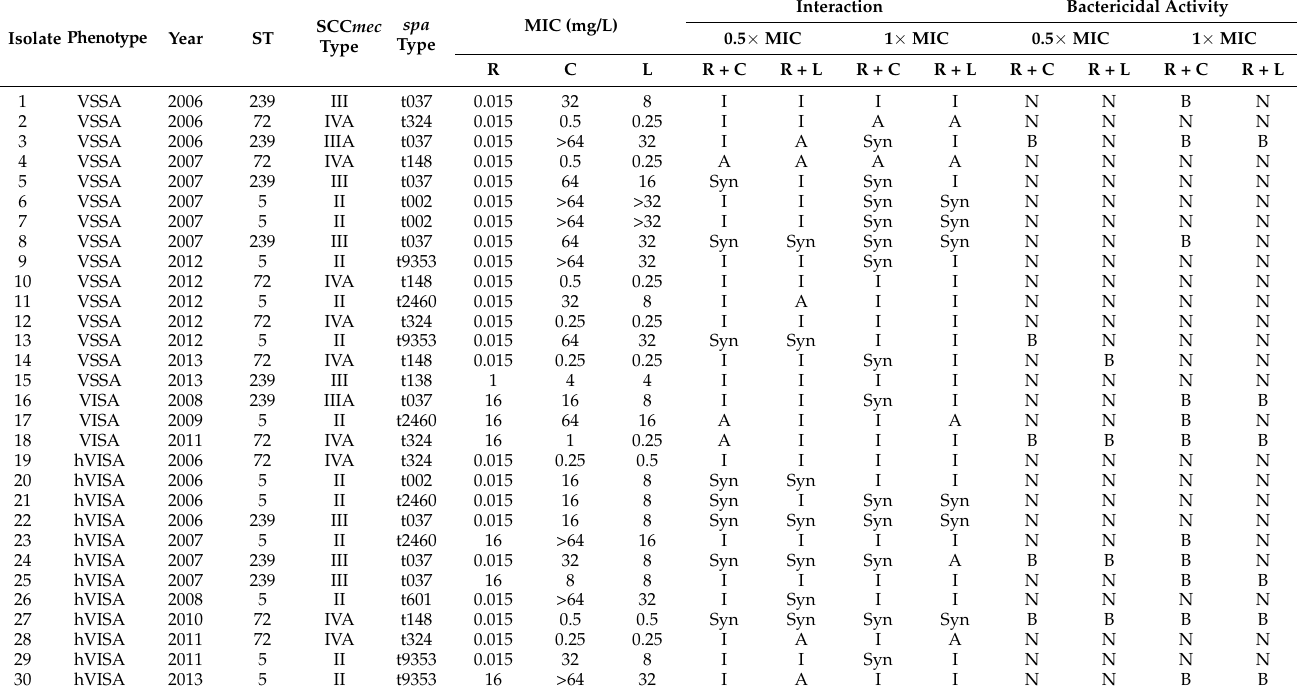
Table 2. Microbiological and molecular characteristics of methicillin-resistant Staphylococcus aureus strains and comparison of rifampin interactions with ciprofloxacin and levofloxacin.